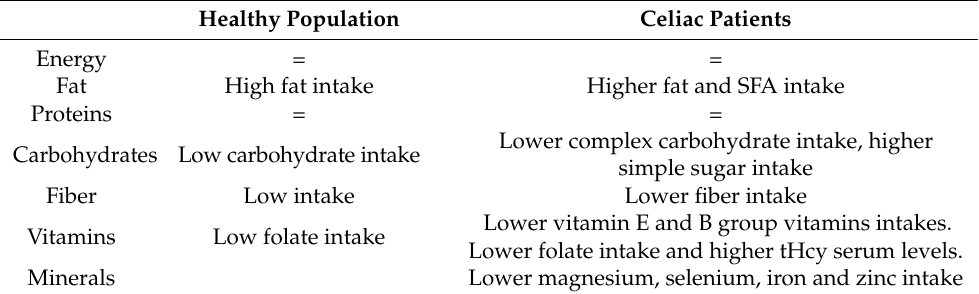
Table 5. Differences between celiac patients and healthy general